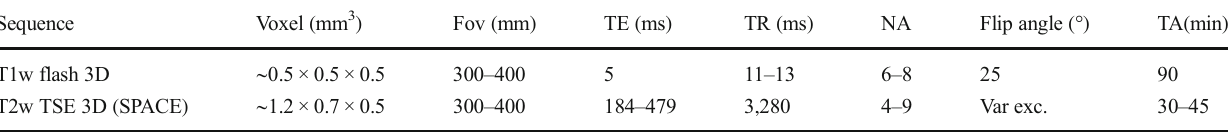
Summary of the MRI sequence parameters